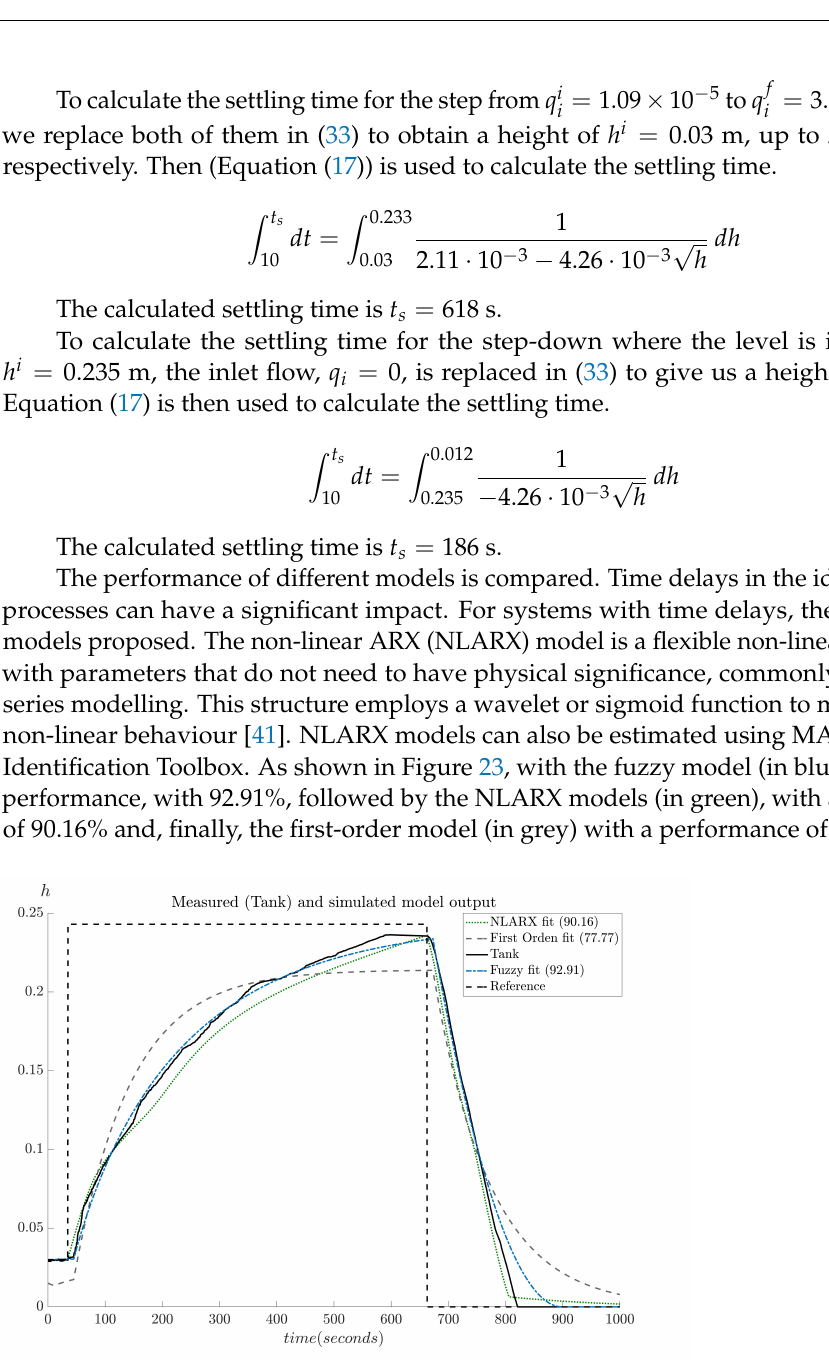
Figure 23. Performance comparison of different